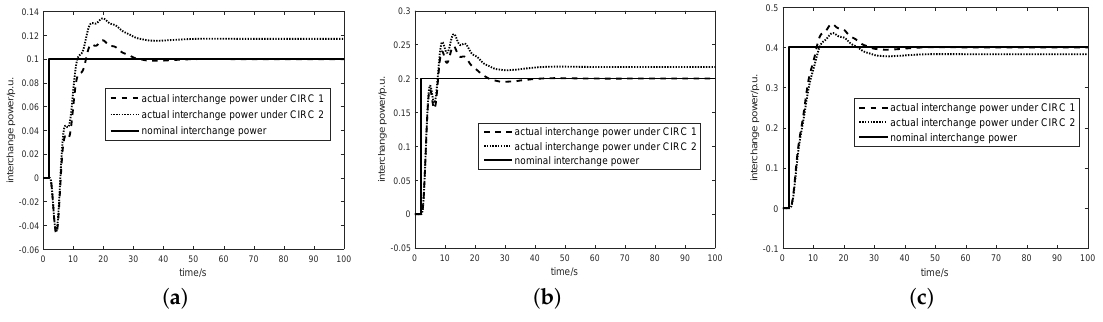
Figure 9. Simulation results in Sections 5.1 (Condition (7) holds) and 5.2 (Condition (7) does not hold). ( a ) Interchange power between Areas 1 and 2; ( b ) interchange power between Areas 2 and 3; and ( c ) interchange power between Areas 3 and 1.